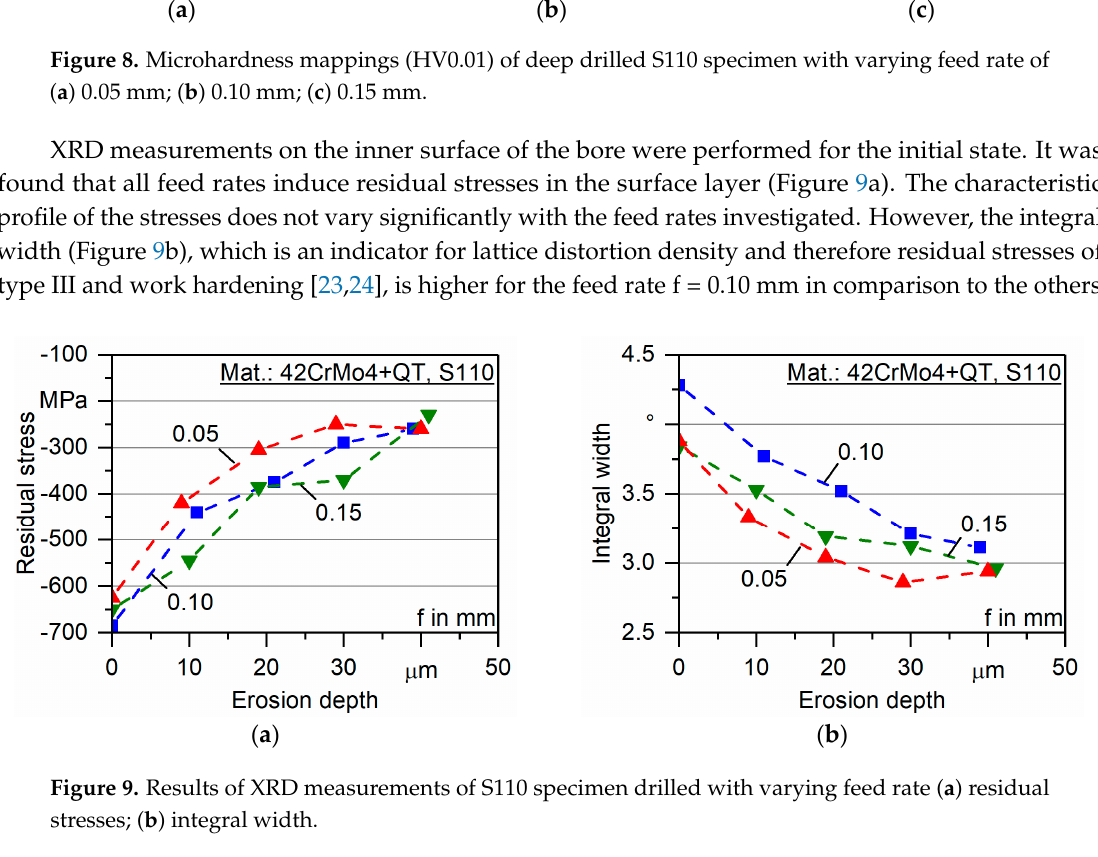
Figure 8. Microhardness mappings (HV0.01) of deep drilled S110 specimen with varying feed rate of ( a ) 0.05 mm; ( b ) 0.10 mm; ( c ) 0.15 mm.